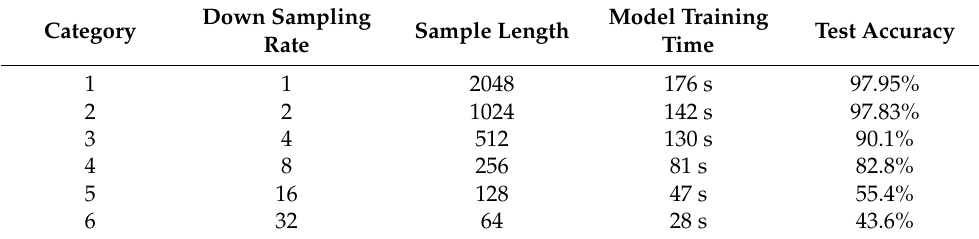
Table 1. Test results of the PHDS method.